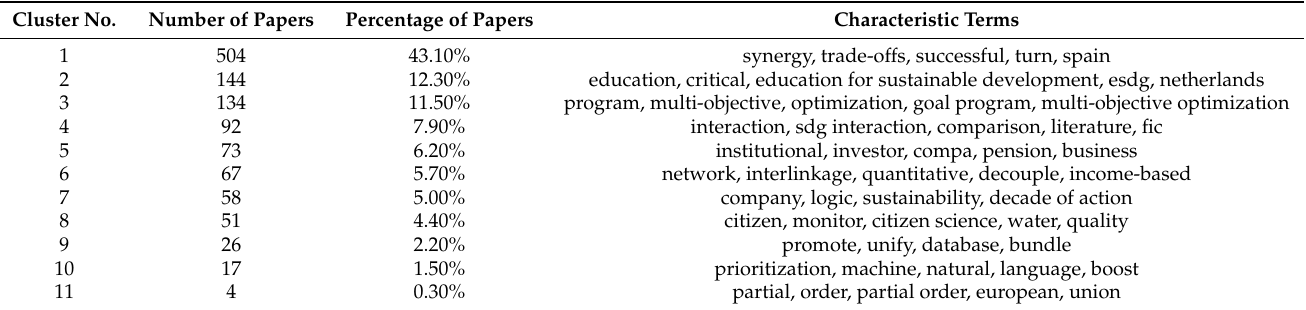
Table 7. The 11 clusters derived by CATAR and the corresponding numbers and percentages of papers, and the characteristic terms.